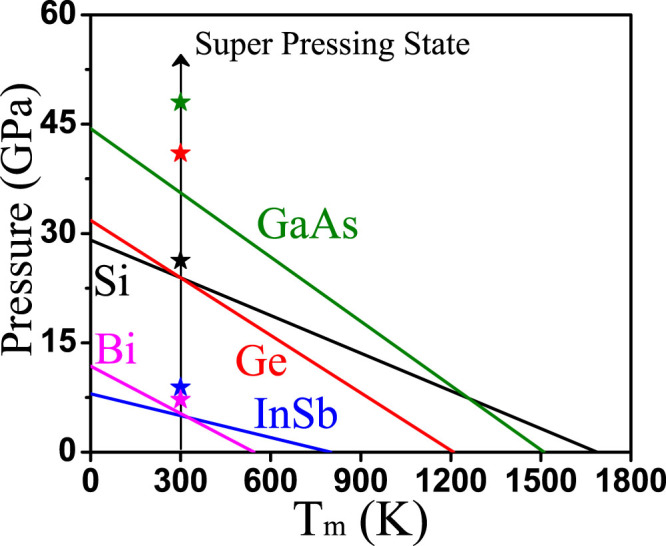
Comparison of the minimum pressure needed to reach "super pressing" state at room temperature with the QES at experimental threshold electron-hole plasma density.The QES at experimental threshold density are marked as stars. The electron-hole densities corresponding to the minimum pressure are 8.2%, 9.9%, 18.5%, 3.2% and 2.2% for Si, Ge, GaAs, InSb and Bi, respectively.